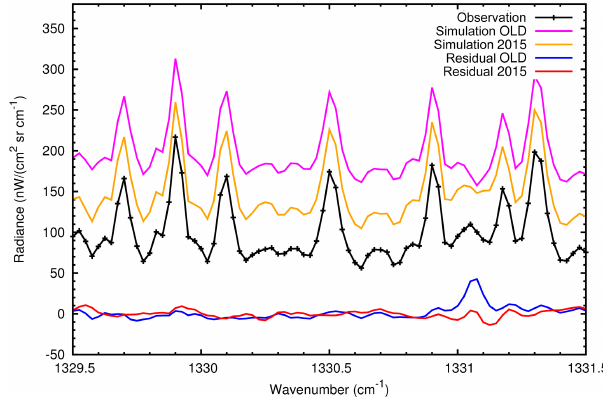
Figure 5. Average MIPAS-observed spectrum (black) in the 1329.5–1331.5cm − 1 spectral region, and simulated spectra with the MIPAS-OLD (magenta line) and the MIPAS-2015 (orange line) HNO 3 linelists. For better readability of the plot, the average orange and magenta lines were shifted by 50 and 100nW ( cm 2 srcm − 1 ) − 1 respectively. The blue and the red lines are the residuals obtained with the MIPAS-OLD and the MIPAS-2015 linelists